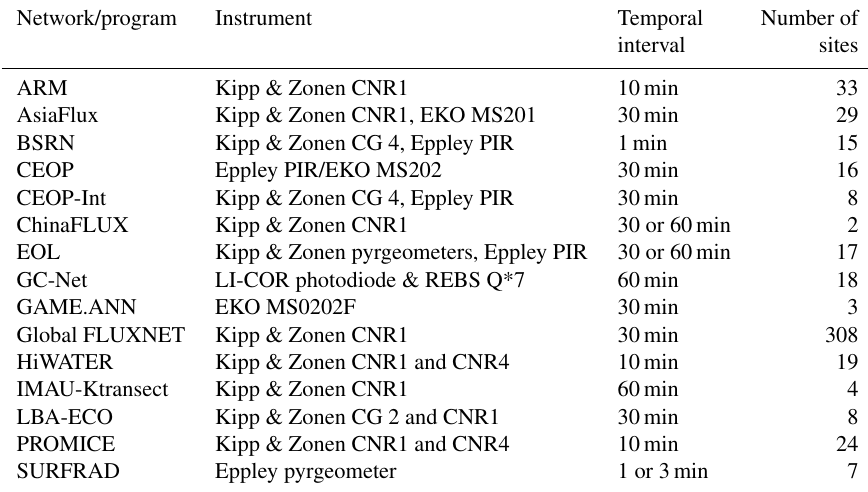
Table 2. Information about the observation networks. ARM: Atmospheric Radiation Measurement; BSRN: Baseline Surface Radiation Network; CEOP-Int: Coordinated Enhanced Observing Period; CEOP: Coordinated Enhanced Observation Network of China; EOL: Earth Observing Laboratory; GAME.ANN: GEWEX Asian Monsoon Experiment; GC-Net: Greenland Climate Network; IMAU-Ktransect: In- stitute for Marine and Atmospheric Research Ice and Climate; LBA-ECO: Large-Scale Biosphere-Atmosphere Experience; PROMICE: Programme for Monitoring of the Greenland Ice Sheet; SURFRAD: Surface Radiation Budget Network.